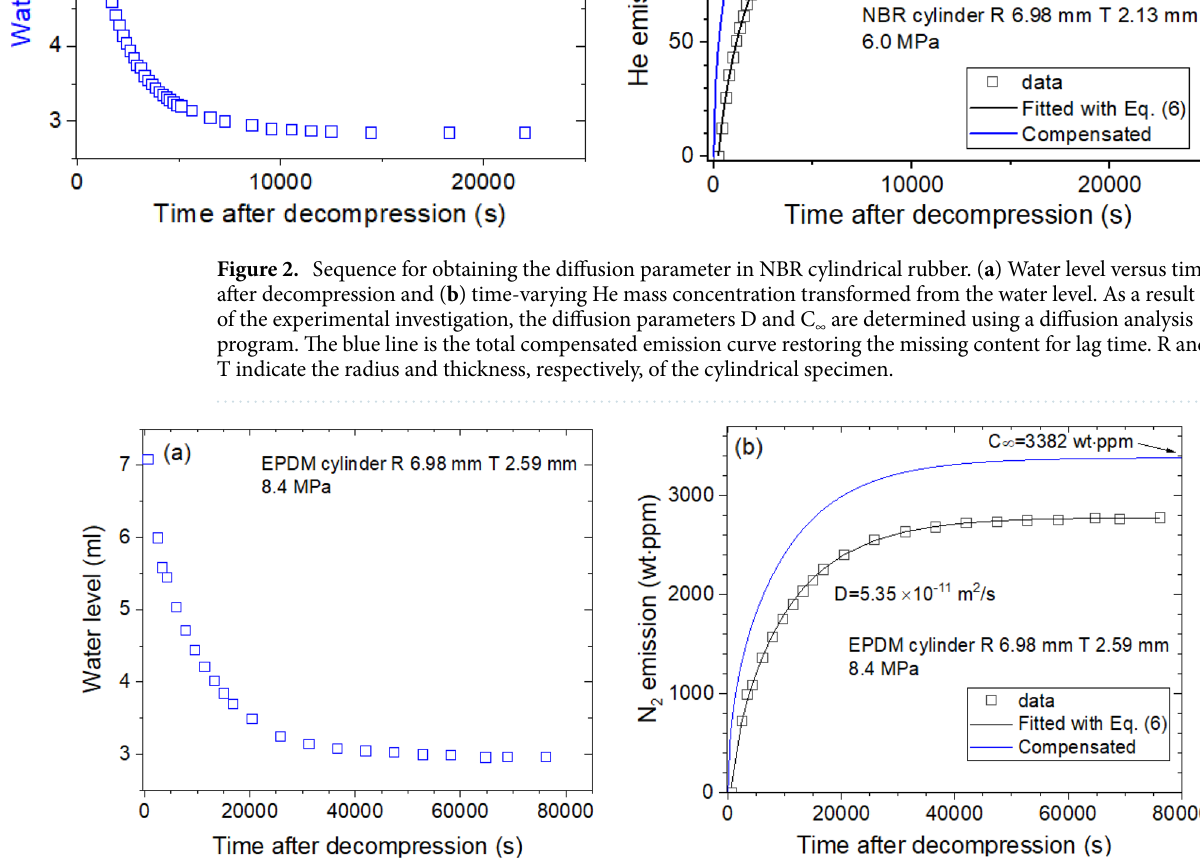
Figure 3. Sequence for obtaining the diffusion parameter in EPDM cylindrical rubber. ( a ) Water level versus time after decompression and ( b ) time-varying N 2 mass concentration transformed from the water level. As a result of the experimental investigation, the diffusion parameters D and C∞ are determined using a diffusion analysis program. The blue line is the total compensated emission curve restoring the missing content for lag time. R and T indicate the radius and thickness, respectively, of the cylindrical